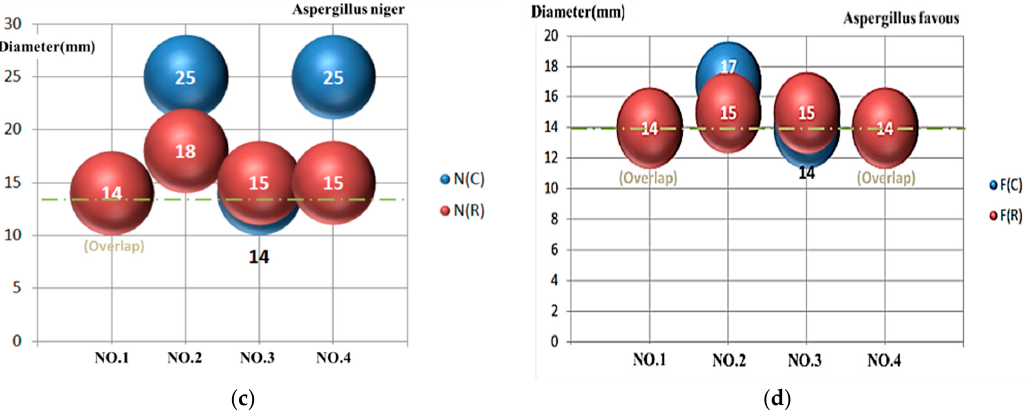
Figure 14. Comparison of microbial control tests: ( a ) bathroom sample; ( b ) Penicillium; ( c ) Aspergillus niger; ( d ) Aspergillus Flavus.